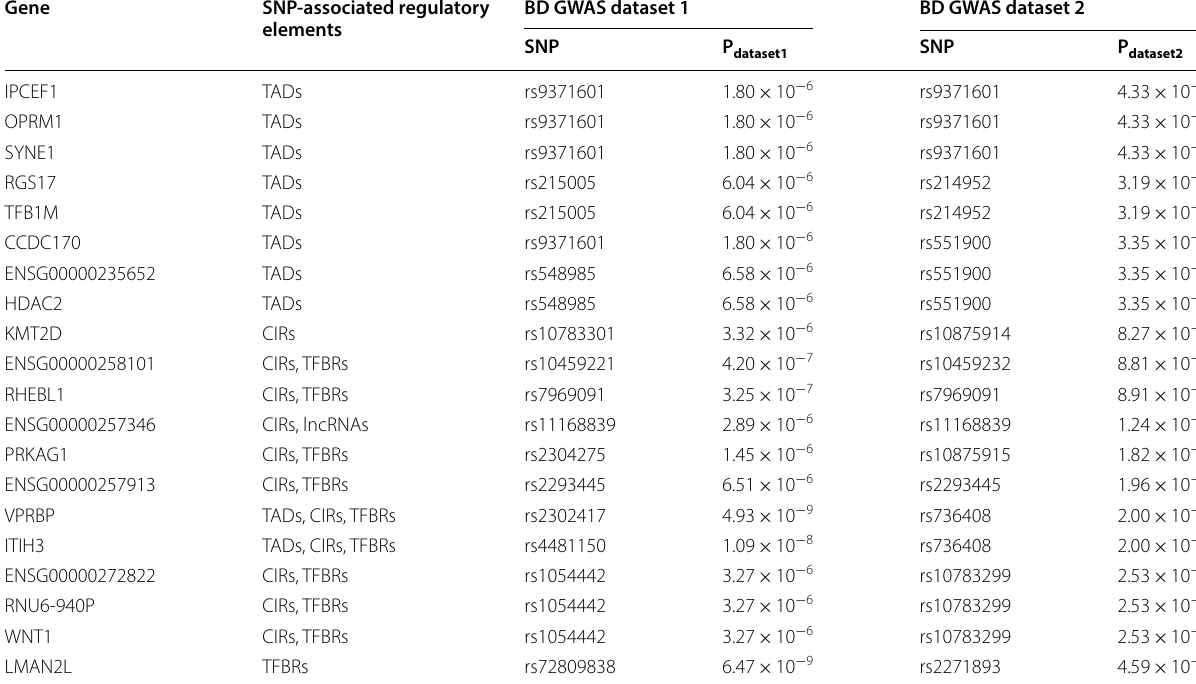
TFBRs transcription factor binding regions, CIRs chromatin interactive regions, long lncRNAs non-coding RNAs regions, TADs topologically associated domains